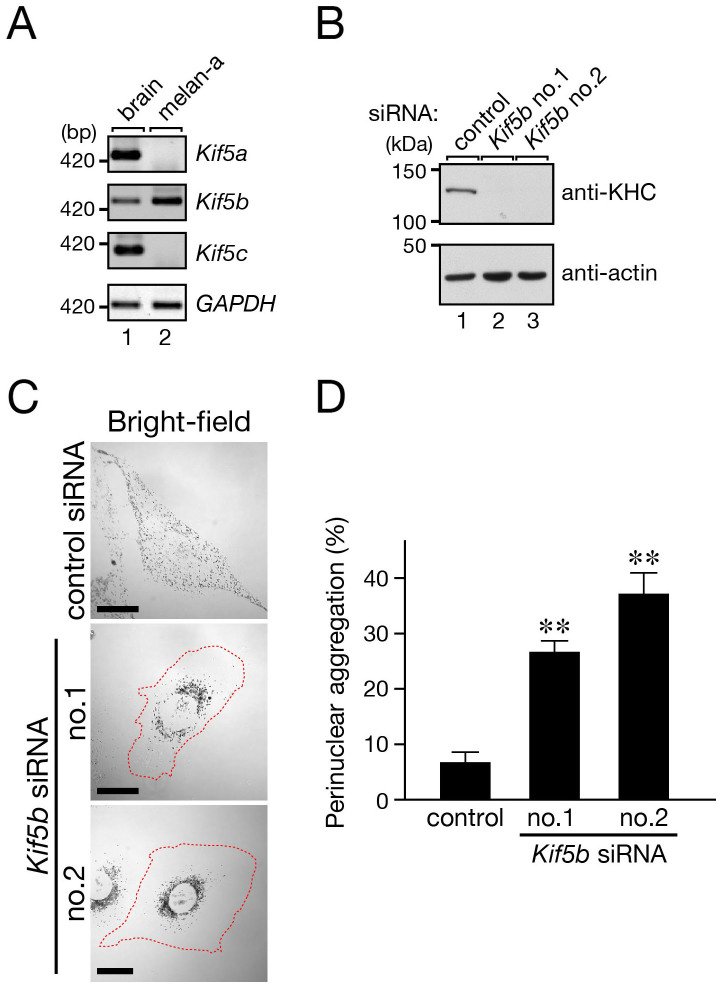
Effect of Kif5b knockdown in melanocytes on melanosome distribution.(A) Expression of Kif5b mRNA and not of Kif5a or Kif5c mRNA in melan-a cells as revealed by an RT-PCR analysis. The results are shown in the form of white/black-reversal images. GAPDH mRNA expression (bottom panel) is shown as a loading control to ensure that equivalent amounts of first-strand cDNA were used for the RT-PCR analysis. The size of the molecular mass markers (bp, base pairs) is shown on the left side of the panel. (B) Knockdown of endogenous Kif5b protein in melan-a cells with the specific Kif5b siRNAs. The positions of the molecular mass markers are shown on the left. (C) Knockdown of Kif5b in melanocytes resulted in perinuclear melanosome aggregation. Melan-a cells were treated with a control siRNA (top panel) or Kif5b siRNAs (bottom two panels). Cells exhibiting perinuclear melanosome aggregation are outlined with a broken line. Note the clear perinuclear melanosome aggregation in the Kif5b-deficient cells (bottom two panels). Scale bars, 20 μm. (D) Quantification of the results shown in (C). The results are expressed as the percentages of cells that exhibited perinuclear melanosome aggregation, and the bars represent the means and S.E. of the data from four independent experiments (n >100). **, p <0.01 in comparison with the control cells (Dunnett's test).